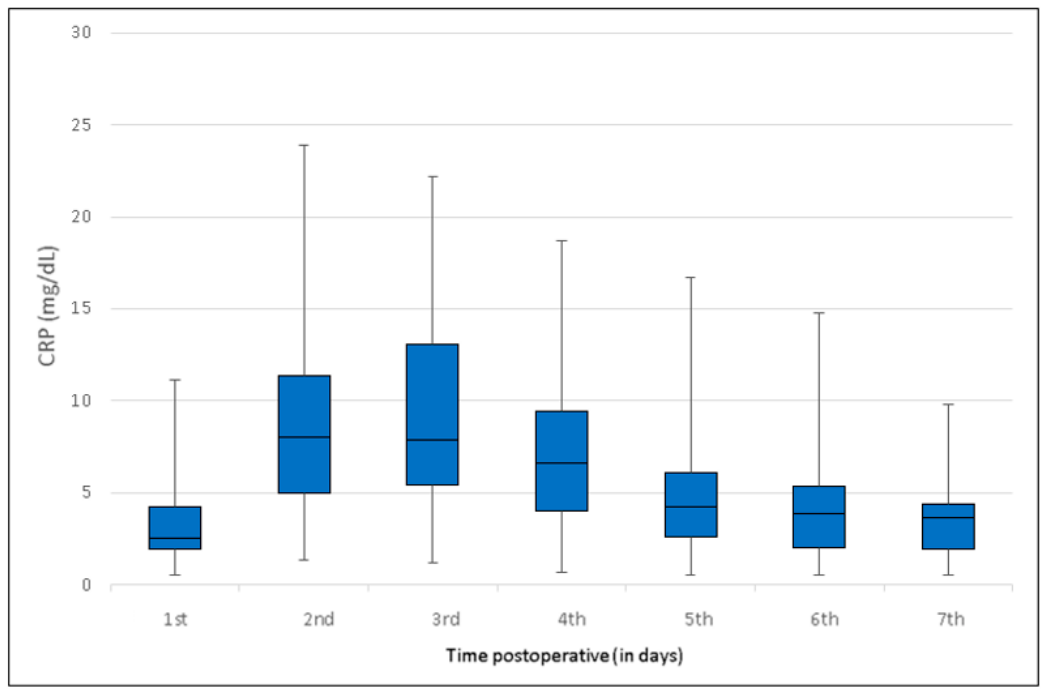
Figure 2. Box-and-whisker plot showing C-reactive protein levels and trend following shoulder arthroplasty in the overall group, illustrating the mean values on days 1 until 7. The blue boxes show the interquartile range (IQR). IQR is the span of the first and third quartiles and is therefore only slightly influenced by outliers. As the IQR refers to the first to third quartiles, a total of 50% of the data are herewith included. The black line indicates the median and the whiskers show the maximum and minimum scattering. Generally, the centrally located median indicates a symmetrical distribution of the values. Table 2. Overview of postoperative C-reactive protein levels in mg/dL following shoulder arthroplasty. Mean values and interquartile range in the brackets.